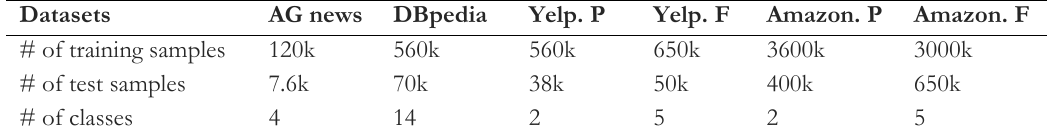
Table 2. Datasets in our